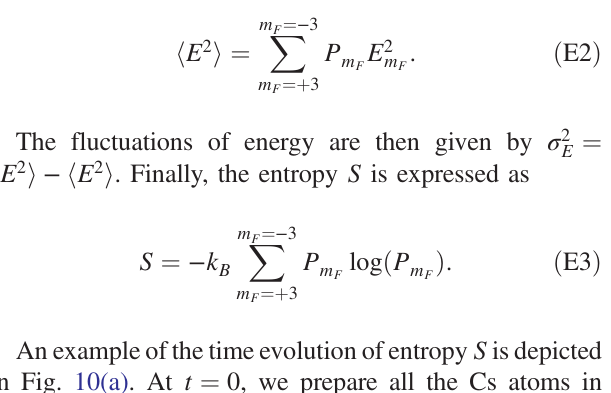
FIG. 9. Simulation of the spin-states ’ dynamics of Cs immersed ¼ 7 × 10 3 atoms at T ¼ 400 nK and B ¼ in a Rb bath with N Rb 10 mG [expected endoergic fraction p ð B; T Þ ¼ 0 . 84 ]. The seven ∈ ½ − 3 ; − 2 ; − 1 ; 0 ; 1 ; 2 ; 3 (cid:2) ) are plotted. The spin states ( m F; Cs steady state is reached beyond 3-s interaction time.